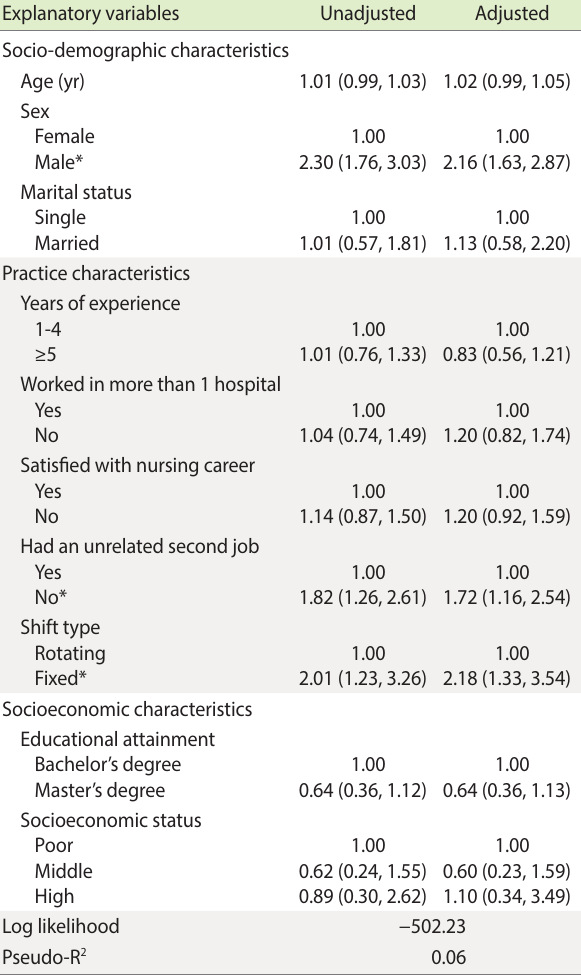
Table 4. Results of negative binomial regression analysis of the fre- quency of medication errors among nurses in Kermanshah, western Iran